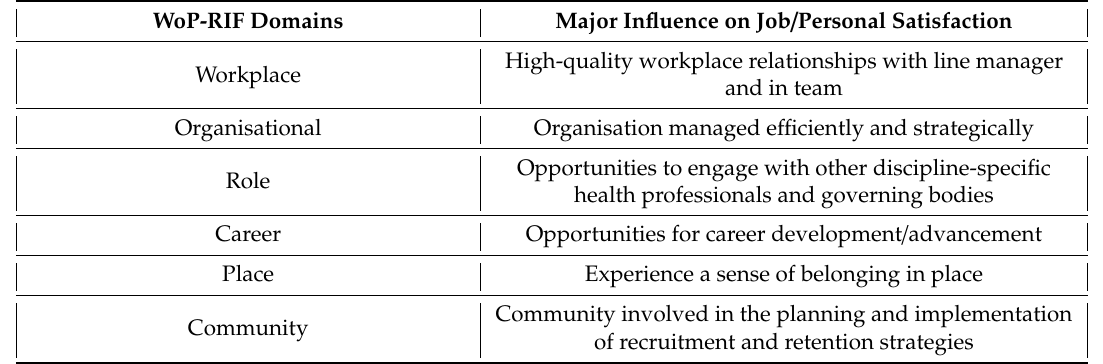
Table 1. Influences on health sta ff ’s job / personal satisfaction in the Whole-of-Person Retention Improvement